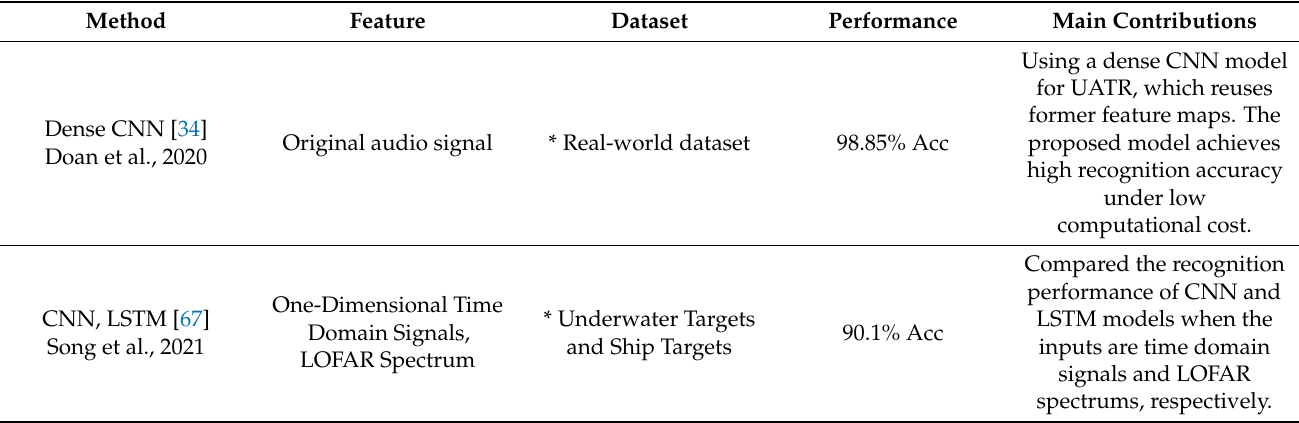
Table 2. An overview of deep learning methods for